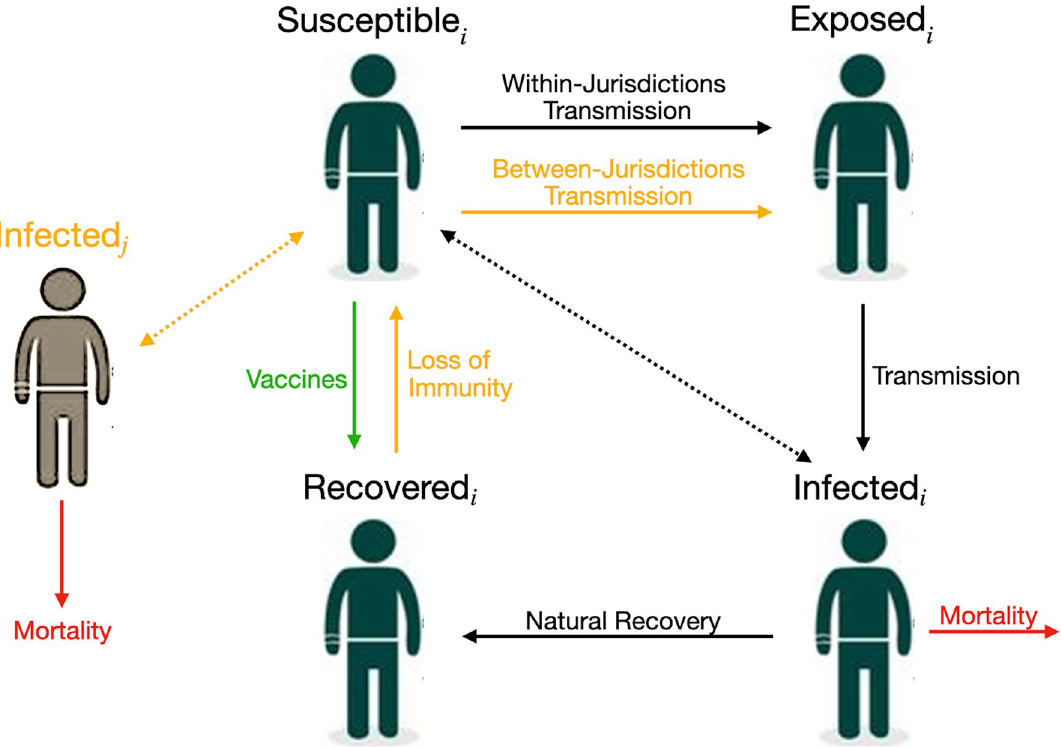
Figure 1. Model interventions and disease transmission pathways for our model of COVID-19. The full lines represent the transition between, or out of, compartments while the dotted lines represent contact between susceptible and infected individuals. Black lines represent situations that do not vary, while yellow lines represent key factors that we vary in our model to see how they impact our results. The green line represents the vaccines and the red line represents